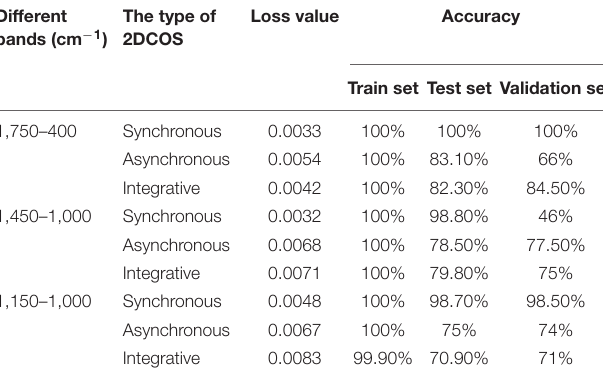
TABLE 2 | The model comparison